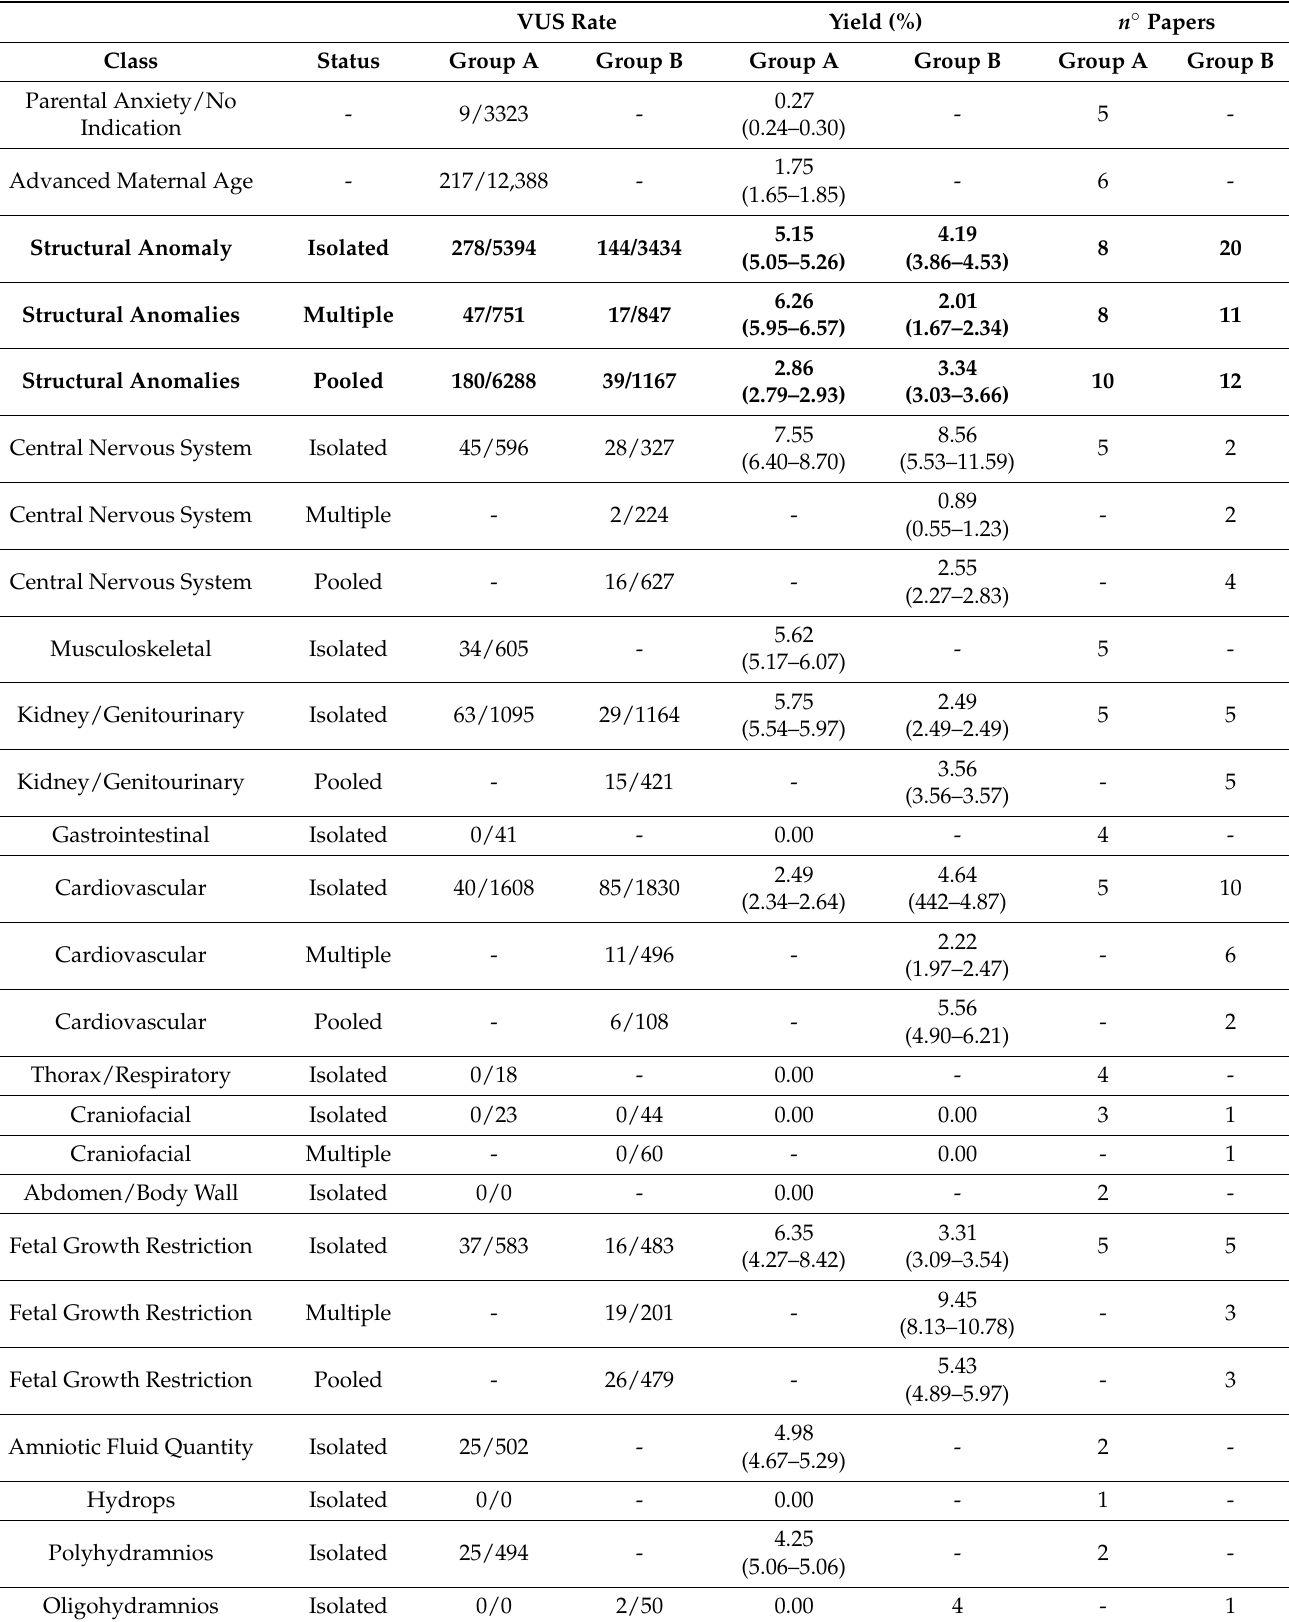
Table 2. CMA—Meta-analysis Group A and B. VUS